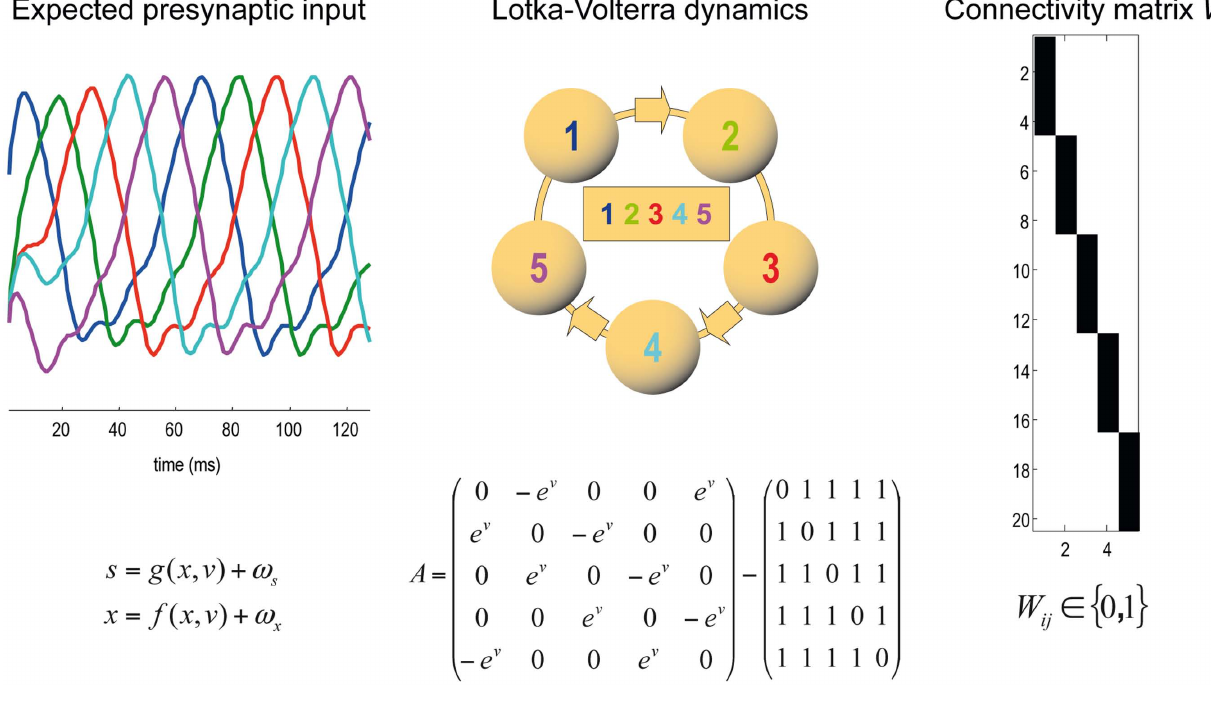
of v to render the speed positive; this could be encoded by something like calcium ion concentration. (Right)The synaptic connectivity matrix W determines which presynaptic axons a specific synapses is connected to. An element W ij in black indicates that there is a connection from presynaptic axon j to synapse i . Each synapse is connected to exactly one presynaptic axon; i.e., each row of matrix W must contain a single one and zeros